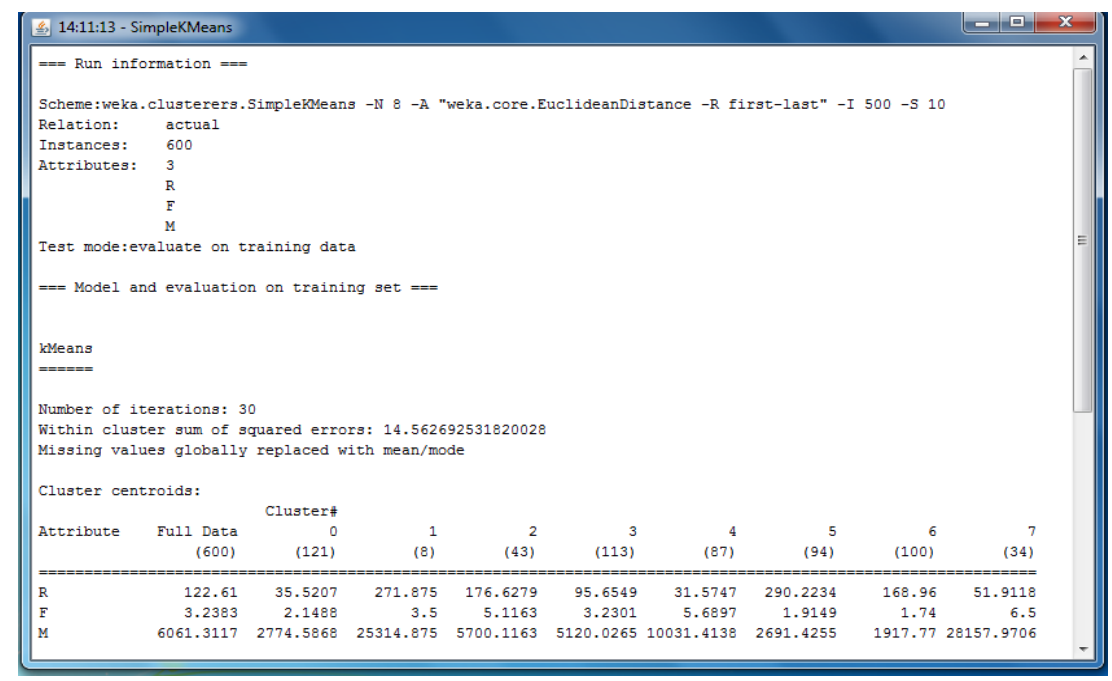
Figure 3. Actual value RFM Clustering Results and SSE for 12 month time frame from 1/1/2010 to